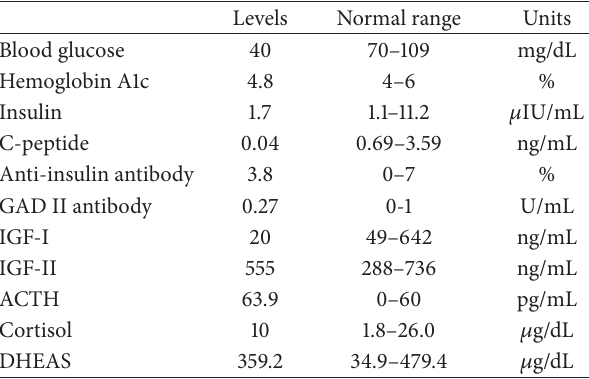
Table 1: Endocrinological data from a patient with hypoglycemia.